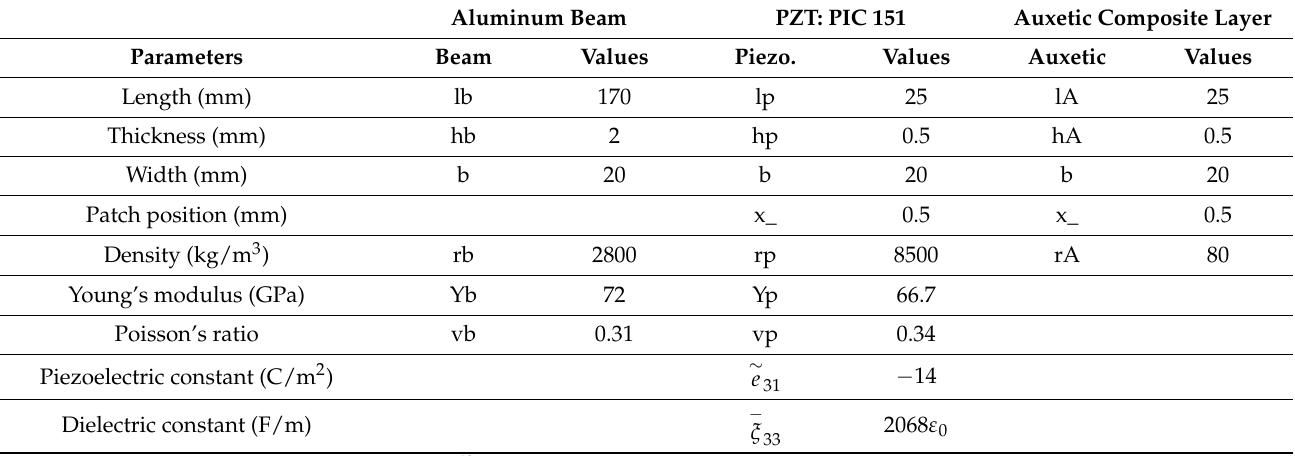
Table 5. Numerical values of system